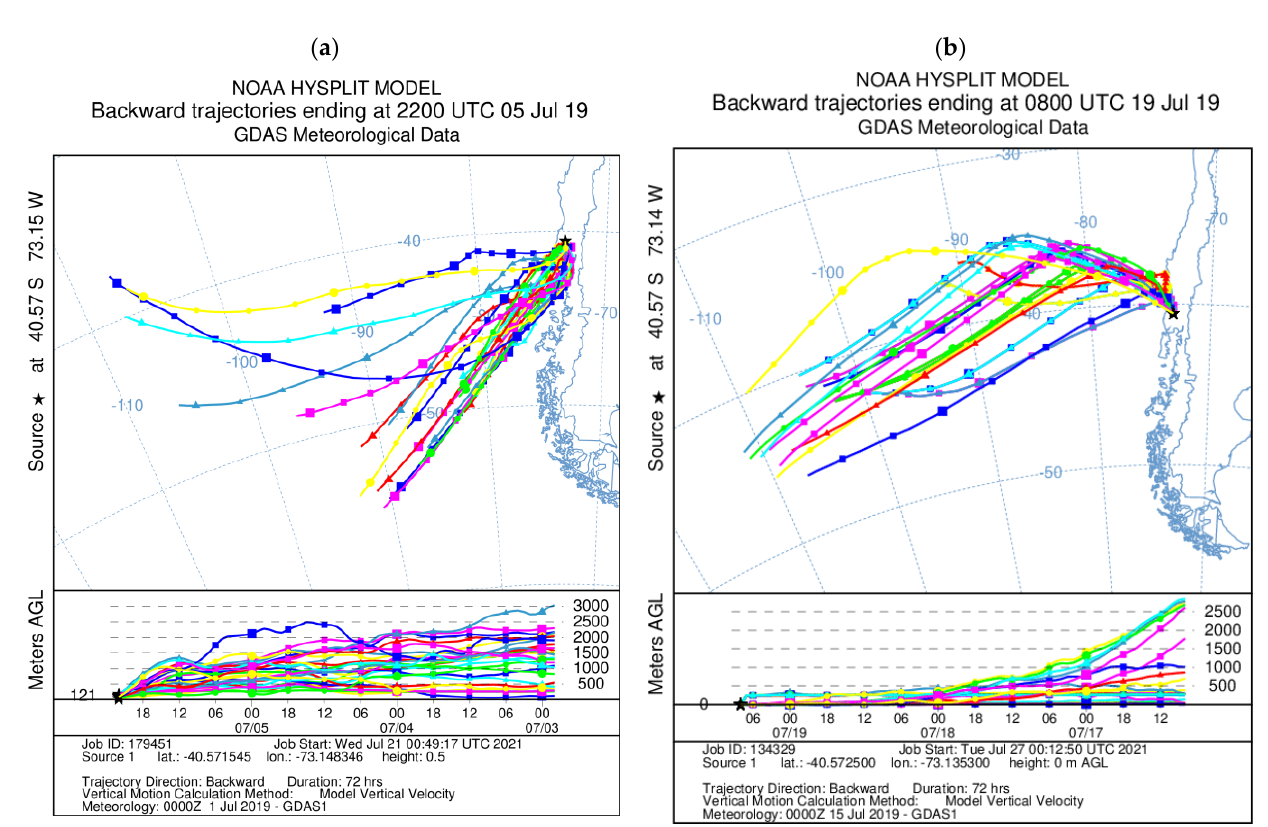
Figure 10. ( a ) 5 July 2019 with a high PM 2.5 concentration and ( b ) 19 July 2019 with a low PM 2.5 concentration.